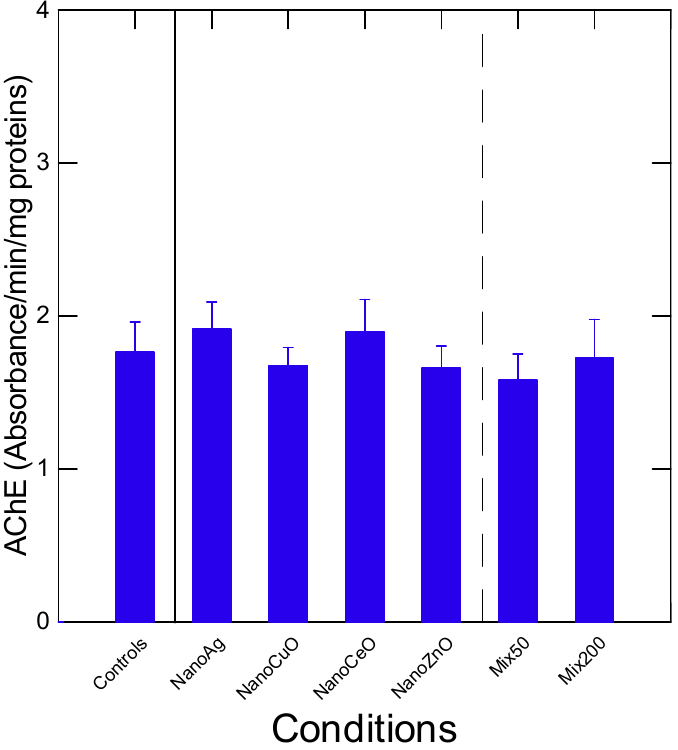
Figure 5. AChE activity in freshwater mussels exposed to nanoparticles and their mixtures. The data represent the mean with the standard deviation.